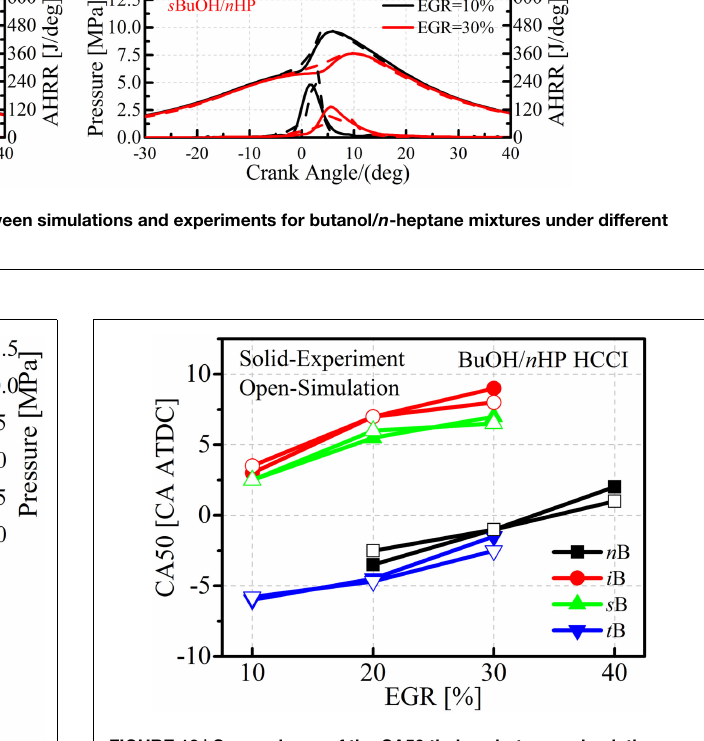
FIGURE 12 | Comparisons of the CA50 timings between simulations and experiments for four butanol/ n -heptane mixtures